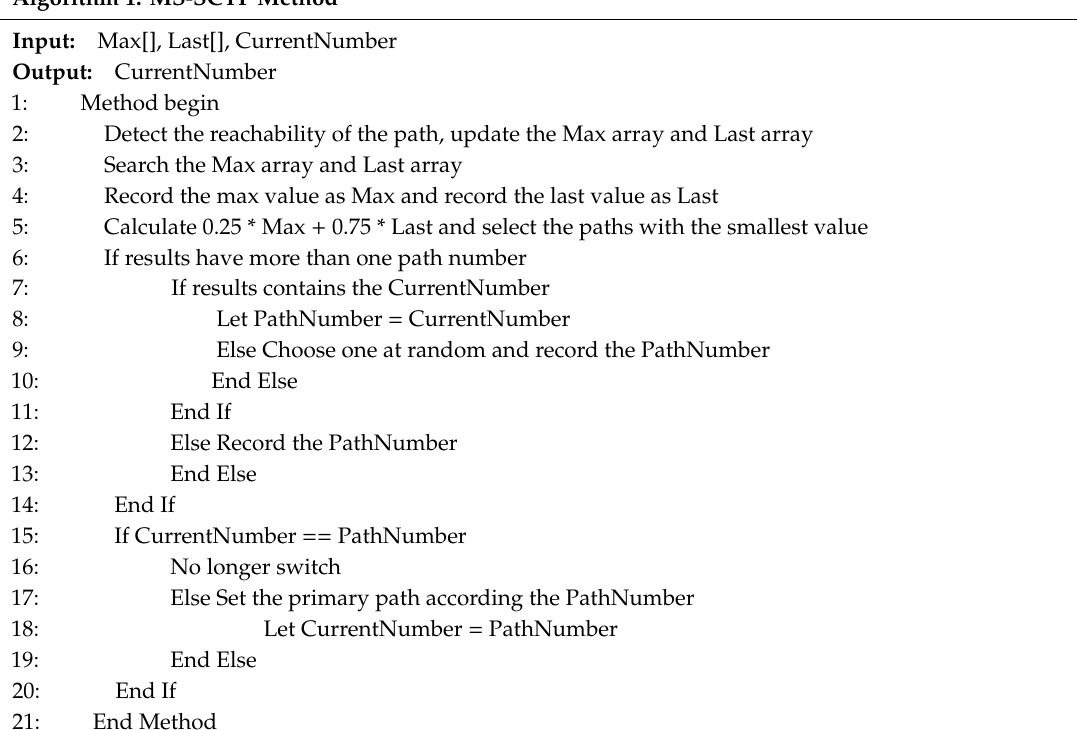
Algorithm 1. MS-SCTP